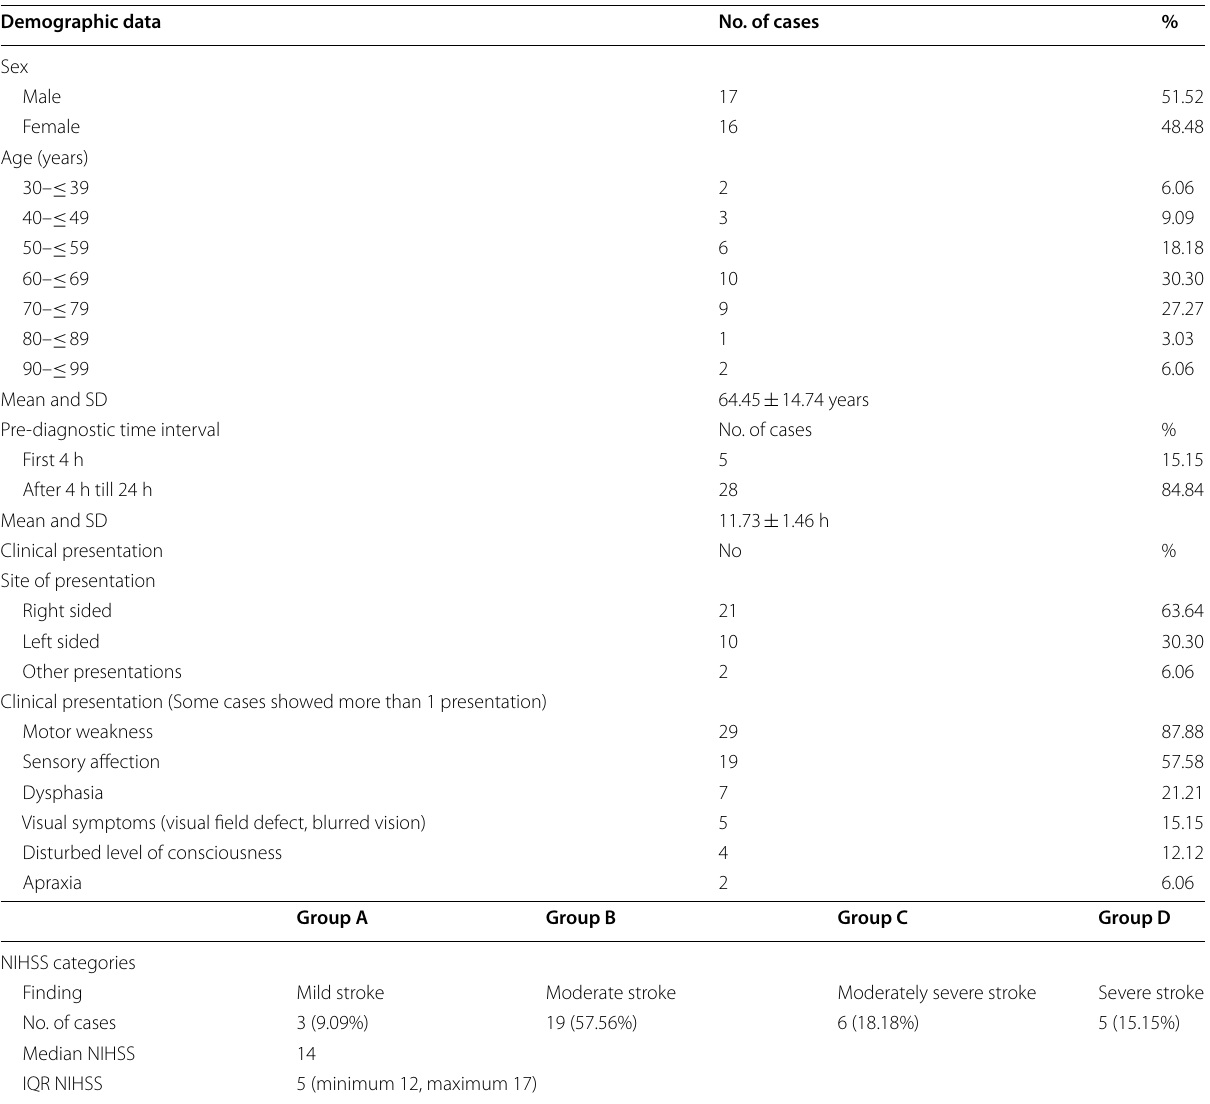
Table 1 Demographic data of the studied acute stroke patients ( n